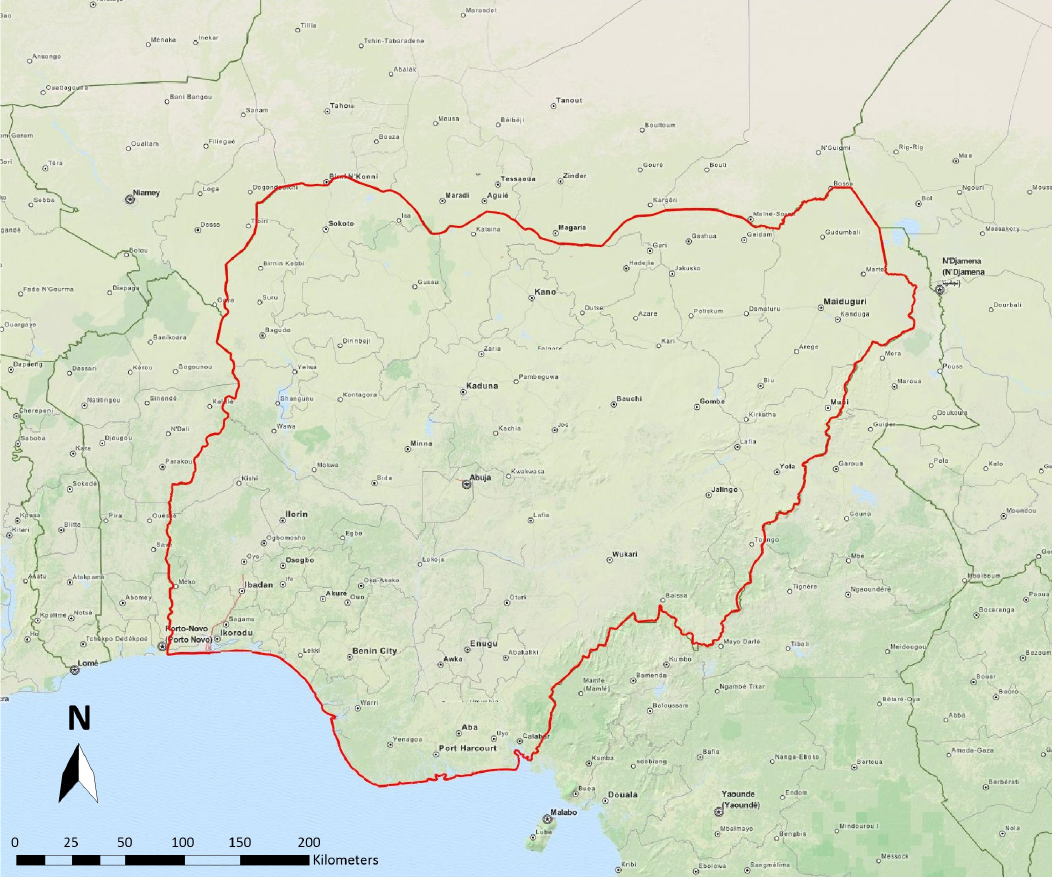
Figure 1. The study area—The entire land of